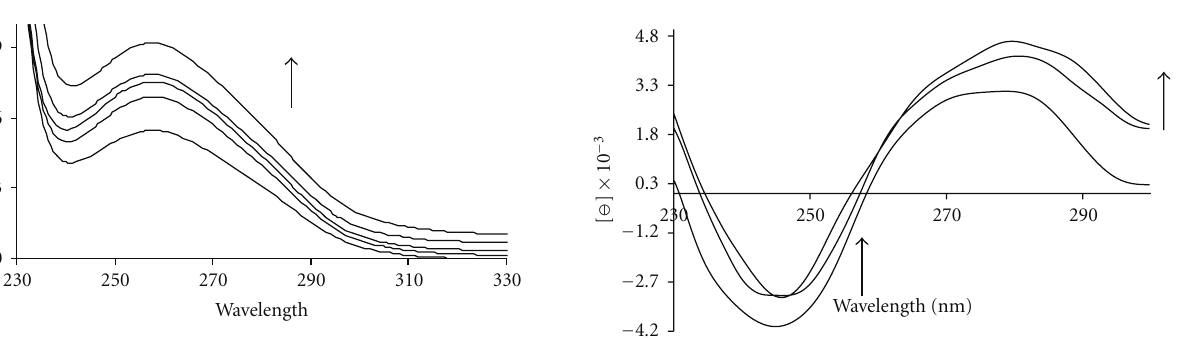
Figure 4: Circular dichroism spectra of CT-DNA (5 × 10 − 5 M) in Tris-HCl (10mM), in the presence of increasing amounts of Pt complex at the following stoichiometric ratios: r i = [com- plex]/[DNA] = 0.0, 0.05, 0.15,